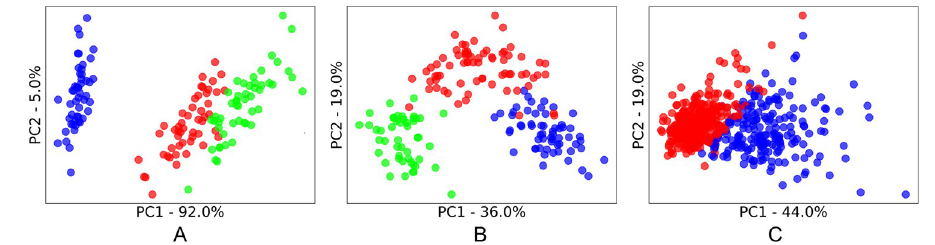
Fig 5. PC1 vs PC2 PCA score plots of the clusters present in the classic ML datasets. A: Iris; B: Wine; C: Breast Cancer. The percentage of original information contained in each principal component is shown on each axis.